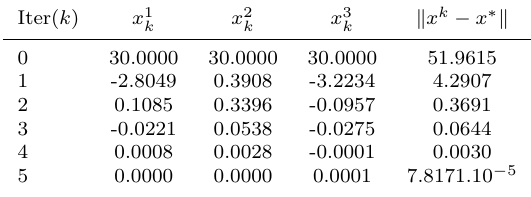
Table 1. Iterations of Algorithm 1 with starting point x 0 = (30 , 30 , 30) T .